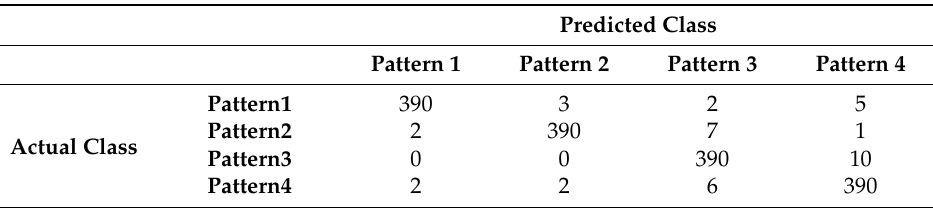
Table 6. Confusion matrix for the four fabric patterns used in the